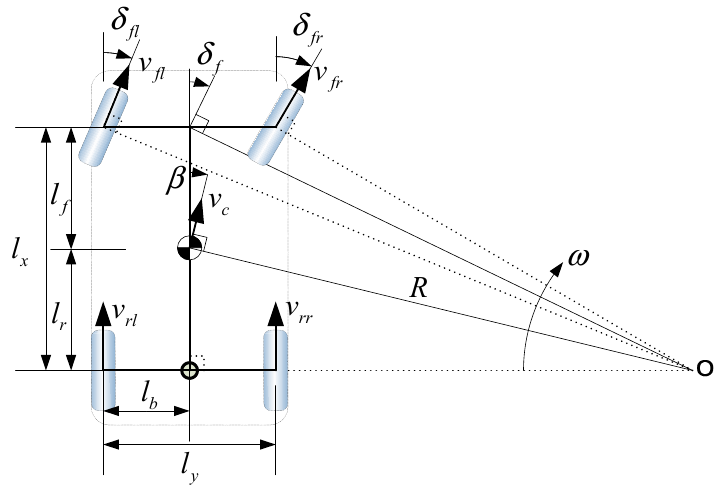
Figure 3. Vehicle geometry for kinematic estimation.